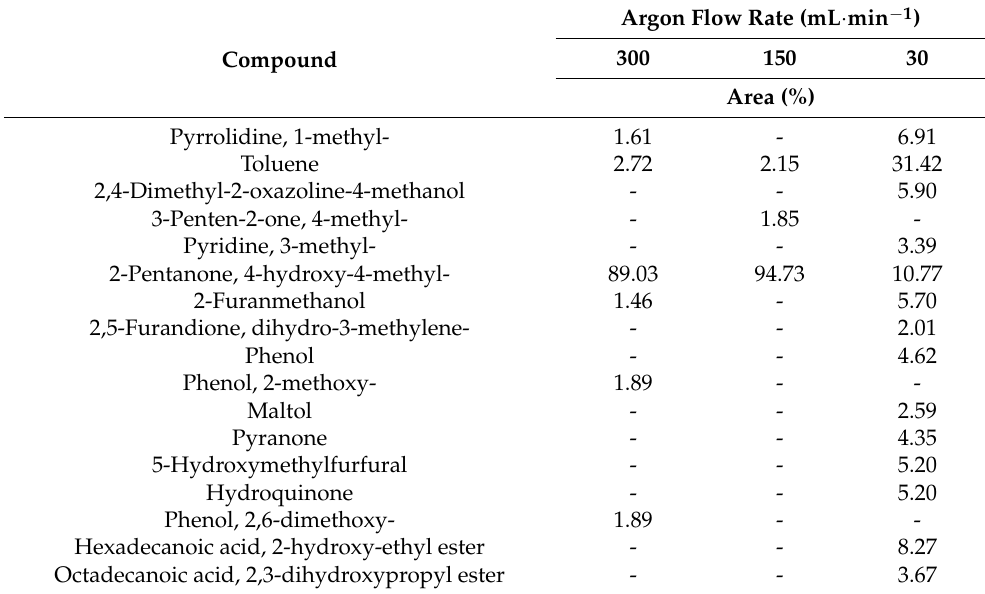
Table 7. Compounds detected in orange pruning bio-oils chromatograms and their relative area percentages using different argon flow rates during the